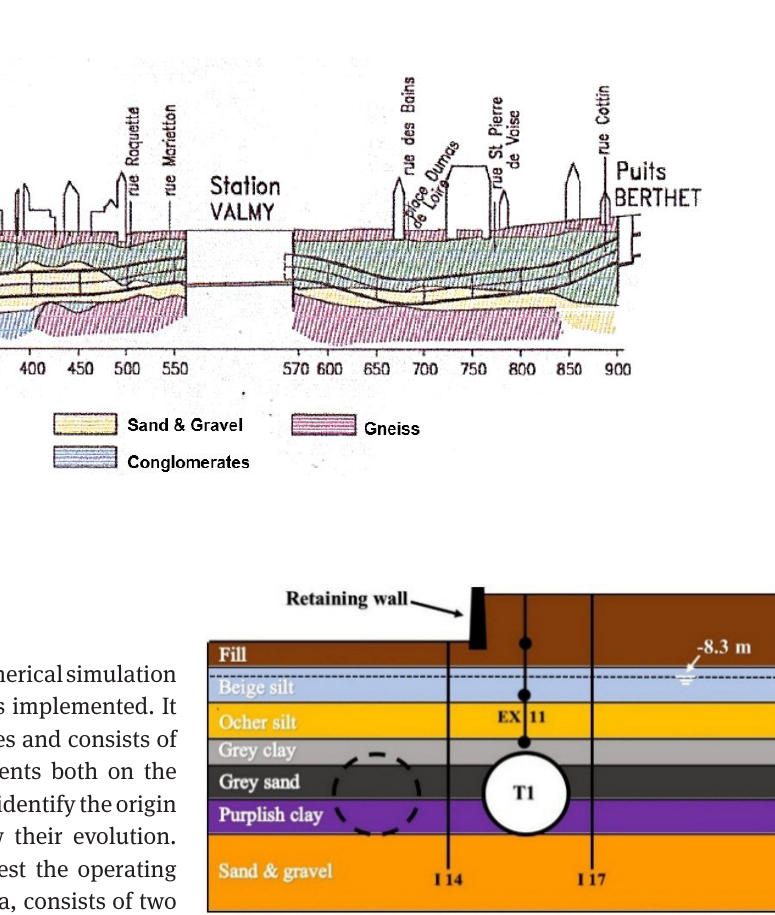
Figure 3: Geological